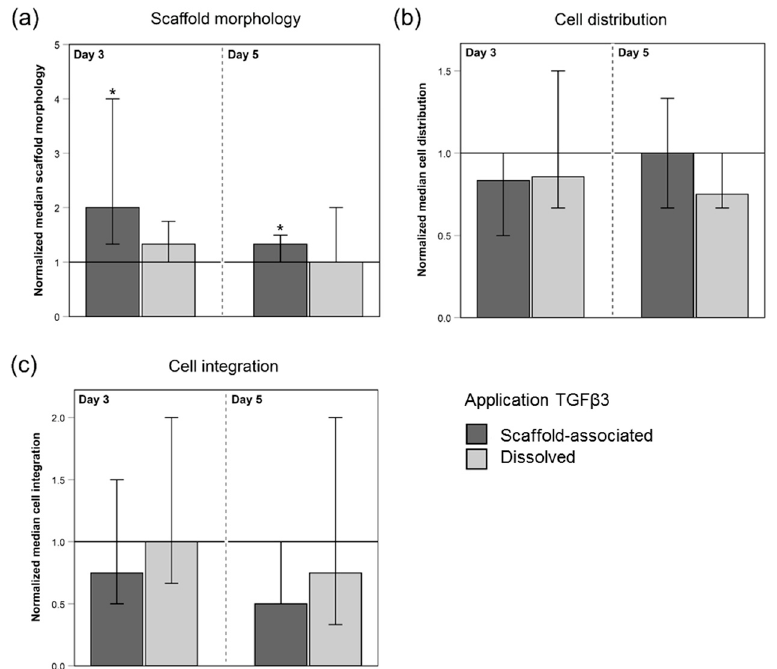
Figure 1. Score points for scaffold morphology ( a ), cell distribution ( b ), and cell integration ( c ) of MSC-seeded tendon scaffolds normalized to the respective internal controls (w/o TGF β 3; indicated by the horizontal line intersecting the x -axis at 1.0). MSC-seeded tendon scaffolds were either directly loaded with TGF β 3 (scaffold-associated) or TGF β 3 was added as a cell culture medium supplement (dissolved). The morphology of MSC-seeded scaffolds ( a ) in terms of scaffold contraction was assessed macroscopically. Hematoxylin- and eosin-stained paraffin sections of MSC-seeded scaffolds were microscopically evaluated for cell distribution ( b ) and cell integration ( c ) (10× objective). The scoring systems used are given in the Materials and Methods section. The total number of scaffolds within each group was 42 ( n = 42). As an exception to this, for the evaluation of cell distribution ( b ) and cell integration ( c ), there were altered numbers of scaffolds due to the technical processing (scaffolds directly loaded with TGF β 3 at day 3: n = 41; internal control scaffolds (w/o TGF β 3) in the group of directly loaded scaffolds at day 3: n = 39; scaffolds receiving dissolved TGF β 3 at day 5: n = 41). Bars indicate the normalized median values and error bars the 95% confidence interval; * represents significant differences compared to the corresponding untreated control group (w/o TGF β 3) ( p < 0.05).